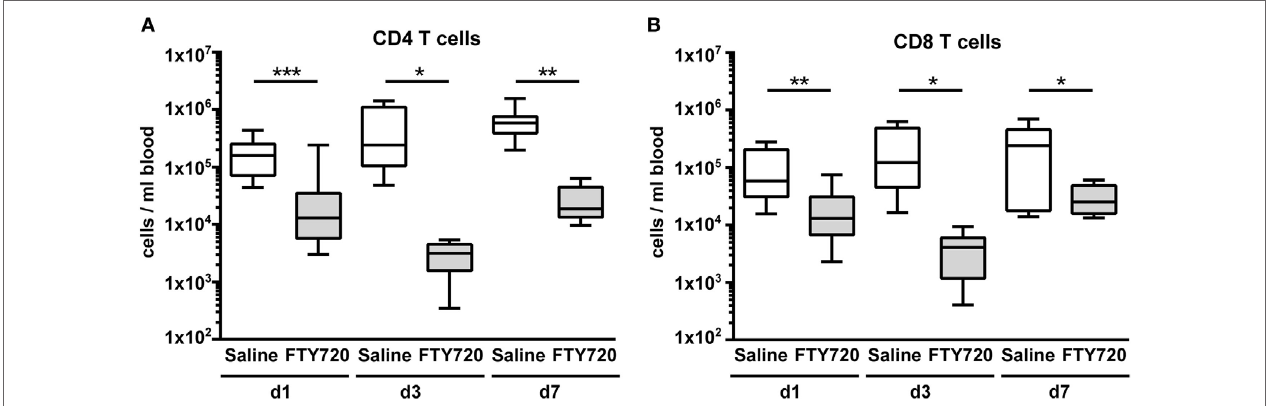
FigUre 1 | A single injection of FTY720 in postnatal day 9 mice results in a strong and sustained depletion of circulating T cells. Naïve 9-day-old C57BL/6 mice received a single intraperitoneal injection of 1 mg/kg FTY720 (in 0.9% NaCl). Saline-treated animals served as control. One, 3, and 7 days after injection, CD4 T cells (a) , CD8 T cells (B) were quantified in the blood via flow cytometry. Blood samples were collected from the right atrium of the heart and transferred into ethylenediaminetetraacetate coated collection tubes followed by erythrocyte lysis. Cell-specific antigens were stained with appropriate antibodies and viable leukocytes were identified by gating for CD45 + cells and FVD − and further divided into CD4 and CD8 T cells (CD19 − , NK1.1 − CD3 + , CD4/8 + ). FTY720 induced a strong and long-lasting reduction in the amount of peripheral CD4 and CD8 T cells by 80–99% compared to saline-treated mice. n = 11–13 for day 1, n = 8–10/ group for day 3, n = 7–8/group for day 7, * p < 0.05, ** p < 0.01, *** p < 0.001, Mann–Whitney test for day 1, unpaired t -test for day 3 and day